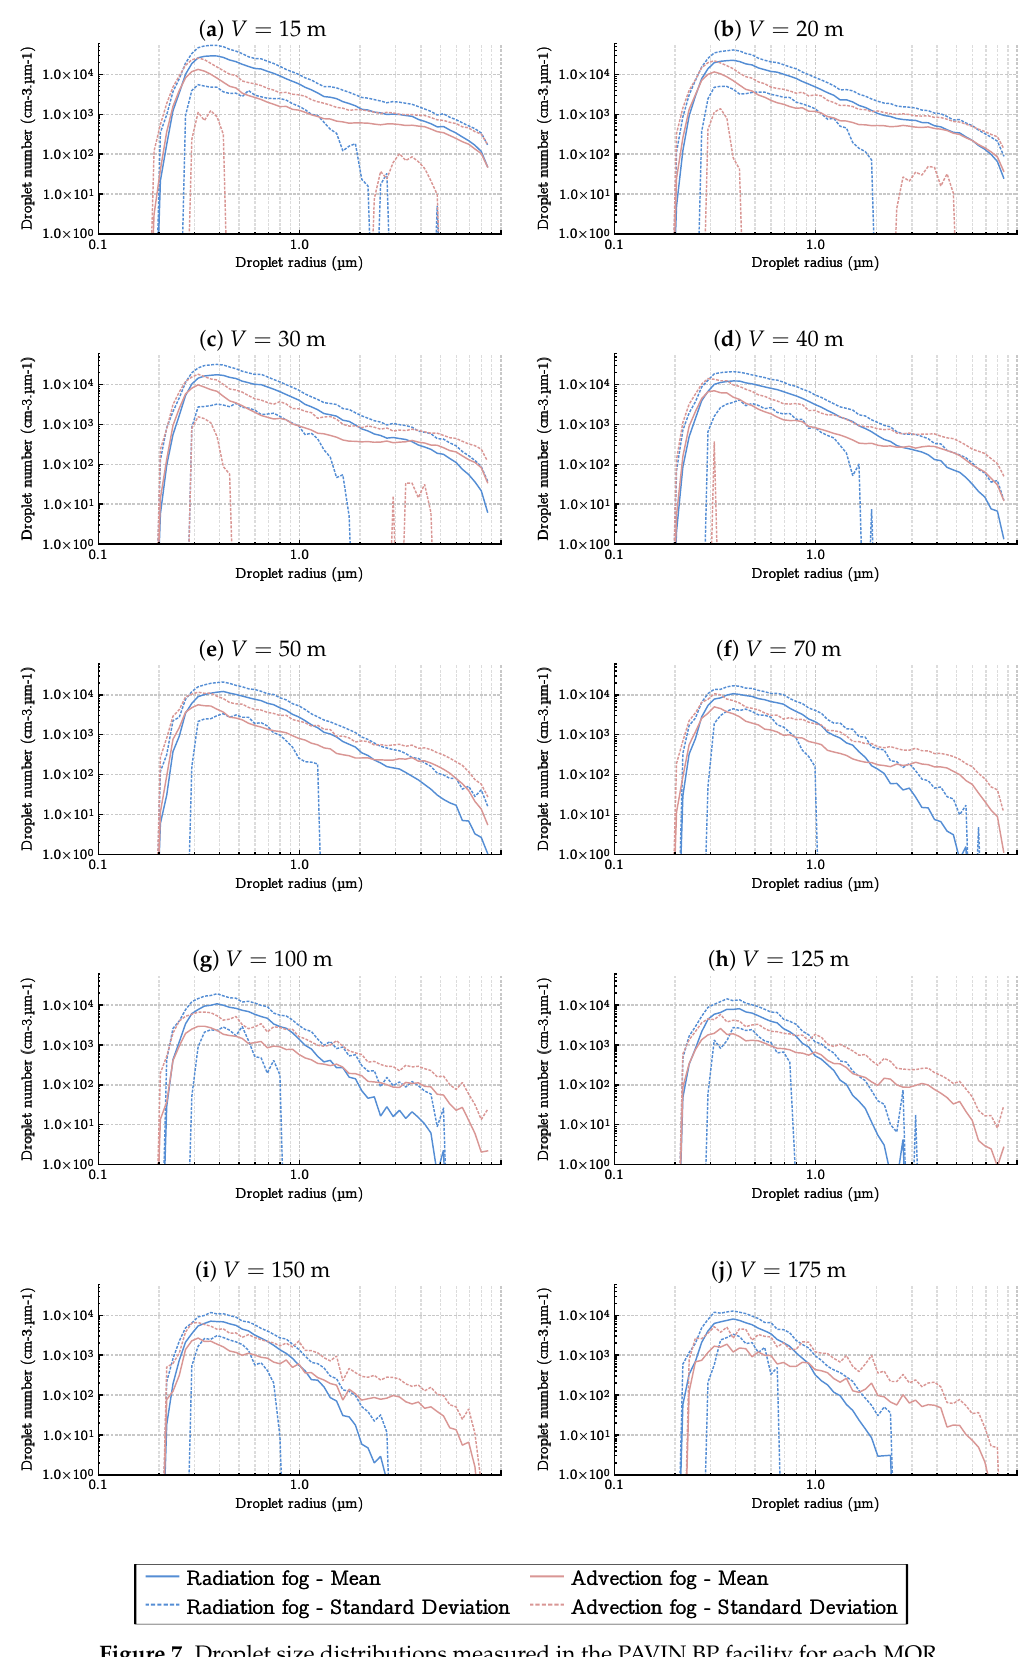
Radiation fog - Mean Radiation fog - Standard Deviation Figure 7. Droplet size distributions measured in the PAVIN BP facility for each